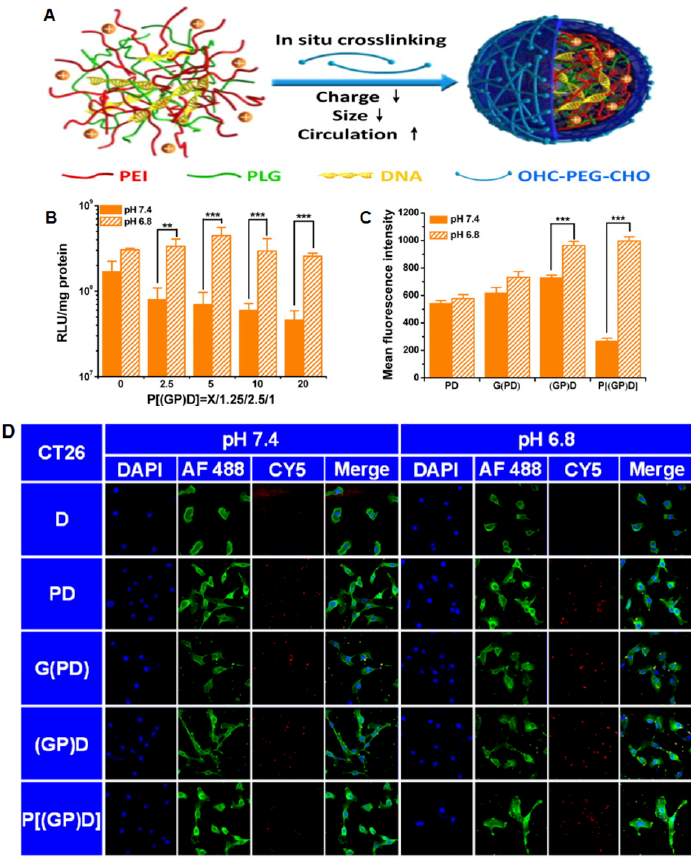
Figure 3. ( A ) Schematic of the pH-sensitive charge/size dual-rebound gene delivery system. ( B ) Transfection efficiency of PEG((PLG/PEI)/DNA) [P((GP)D)] with various PEG mass ratios at different pH values (7.4 and 6.8) in CT26 cells for 2 h. ( C ) Mean fluorescence intensity of cellular uptake of polyethylenimine (PEI)/DNA (PD), poly( L -glutamate) (PLG)/(PEI/DNA) (G(PD)), (PLG/PEI)/DNA((GP)D) and PEG((PLG/PEI)/DNA)(P(GP)D) at different pH values (7.4 and 6.8). ( D ) CLSM images of CT26 cells incubated with D, PD, G(PD), (GP)D and P((GP)D) at different pH